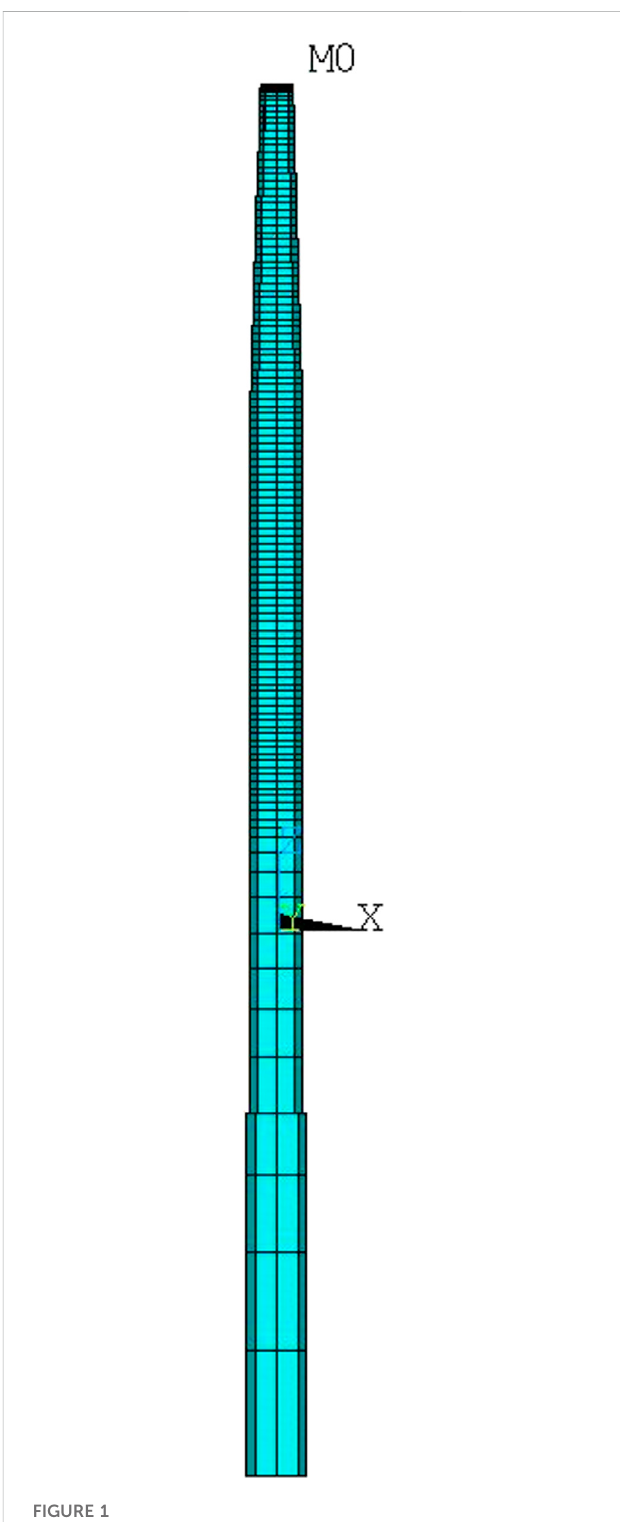
FIGURE 1 The fi nite element model of single pile wind